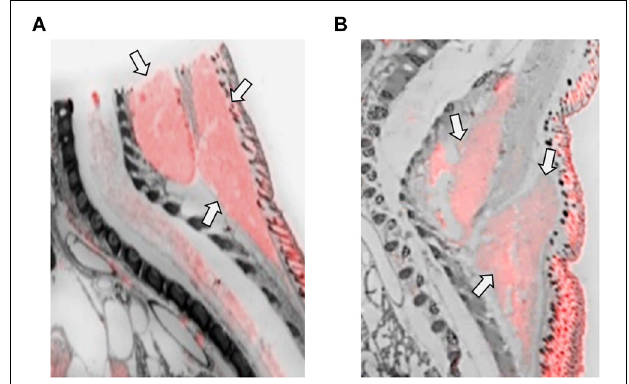
FIGURE 5 | OXTR ligand binding in the brown adipose tissue of neonatal prairie voles. Pseudo-color composites (OXTR in red, cresyl violet counterstain in gray) of (A) female neonatal prairie vole with 0 nM OXT competition and (B) male neonatal prairie vole with 0 nM OXT competition. Females displayed significantly higher OXTR net signal than